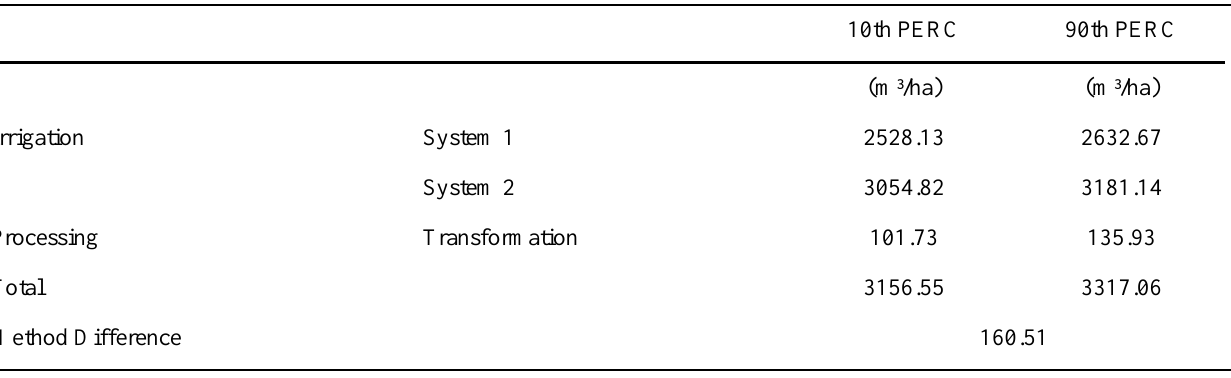
Table 6. Water balance calculated for the production of bioethanol from maize biomass considering two different irrigation systems. Legend: System 1 = pivot; System 2 =